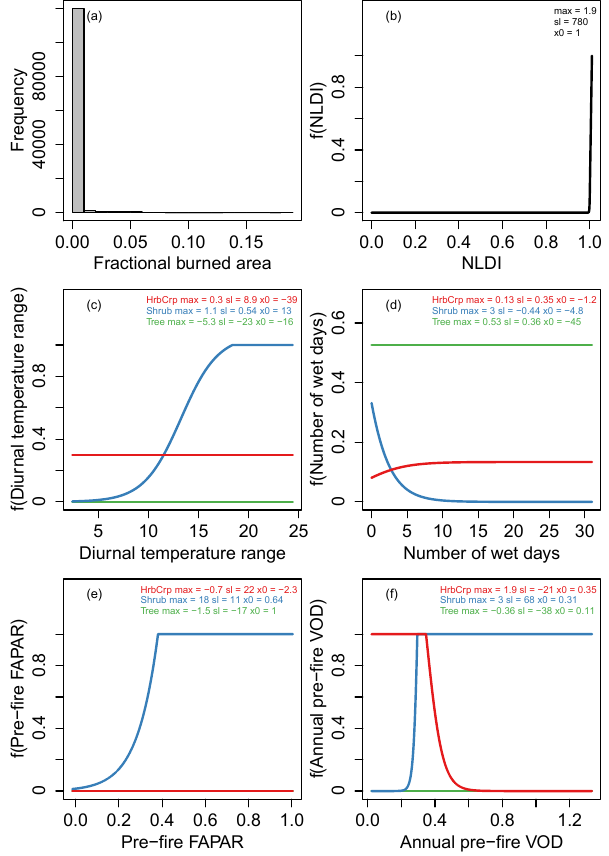
Figure 1. Example of a SOFIA model structure with three land cover groups (i.e. herbaceous vegetation and crops, shrubs, trees) and five controlling factors on fire activity. The example is taken from SOFIA model SF.124421 (Table 2). (a) Histogram of the simulated fractional burned area. Response functions of fractional burned area on the (b) Night Light Development Index, (c) diur- nal temperature range, (d) number of wet days, (e) fraction of ab- sorbed photosynthetic active radiation in the month before a fire, and (f) mean vegetation optical depth in the 12 precedent months. max, sl, and x 0 are parameters of the logistic